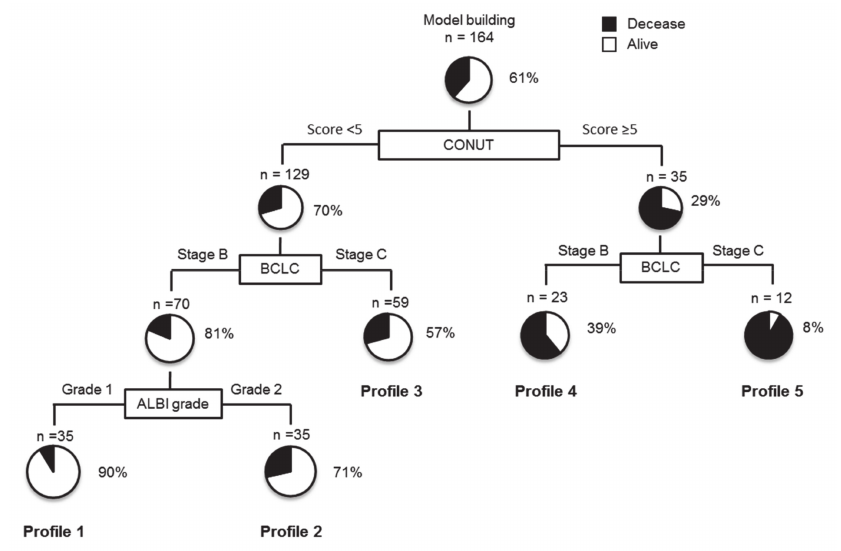
Figure 2. Profiles associated with survival in patients with HCC treated with lenvatinib. Decision tree algorithm for OS. Pie graphs indicate the percentages of alive (white) / deceased (black) patients in each group. Abbreviations: HCC, hepatocellular carcinoma; OS, overall